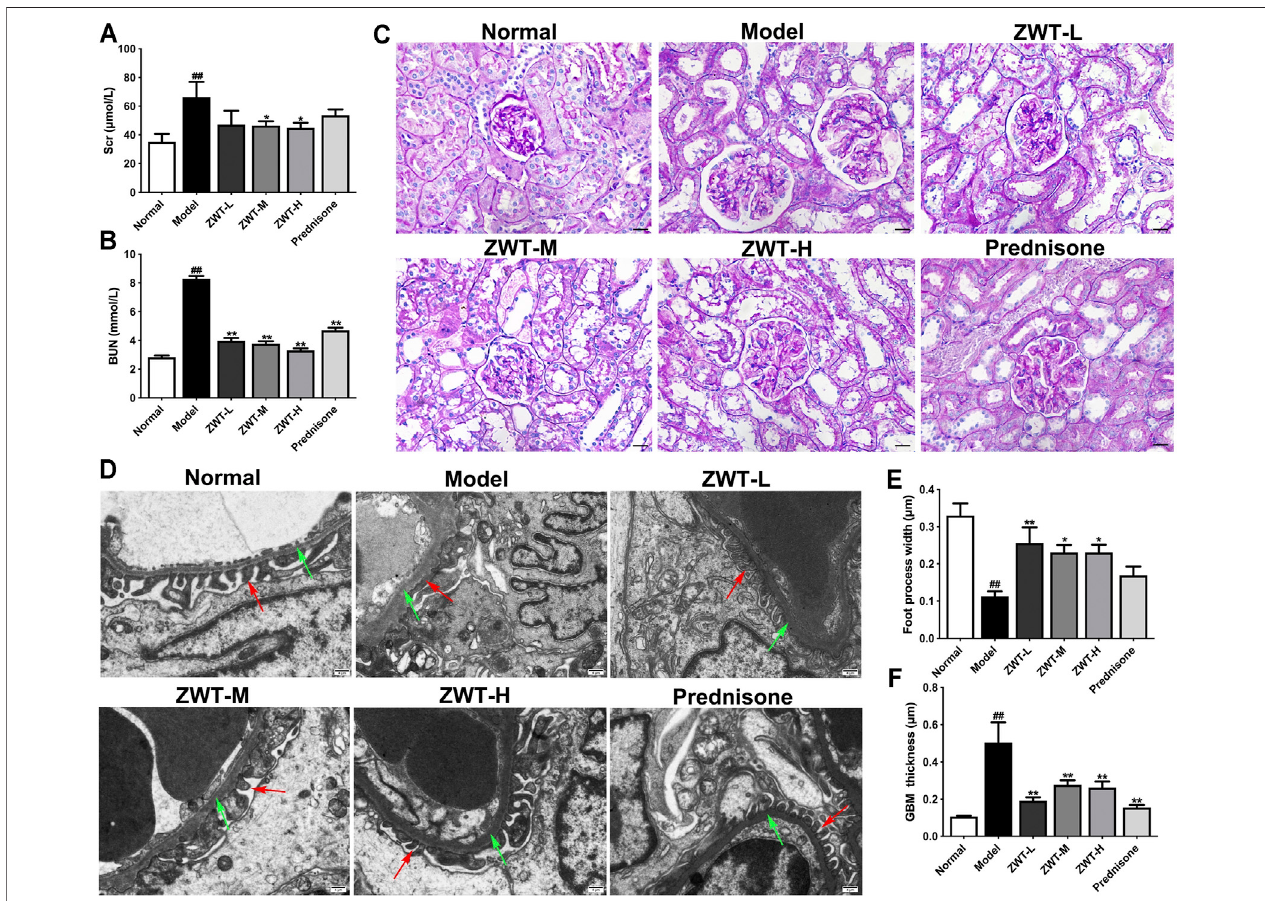
FIGURE2| ZWTprotectedrenalfunctionandstructuralchangesinchronicglomerulonephritis(CGN)modelrats. (A,B) Thelevelsofbloodureanitrogen(BUN)and serum creatinine (Scr). (C) Representative images of PAS-stained renal sections ( × 400 magni fi cation; scale bar (cid:2) 20 μ m). (D) Representative images of renal tissue ultrastructure by transmission electron microscopy ( × 5,000 magni fi cation; scale bar (cid:2) 5 μ m). Red arrows indicate foot process. Green arrows indicate glomerular basement membrane (GBM). (E,F) Quantitative analysis of foot process width and GBM thickness. Data are represented as mean ± SD ( n (cid:2) 8). ## p < 0.01 versus normal group, * p < 0.05 and ** p < 0.01 versus model group. ZWT ameliorated mitochondrial dysfunction in CGN model rats.